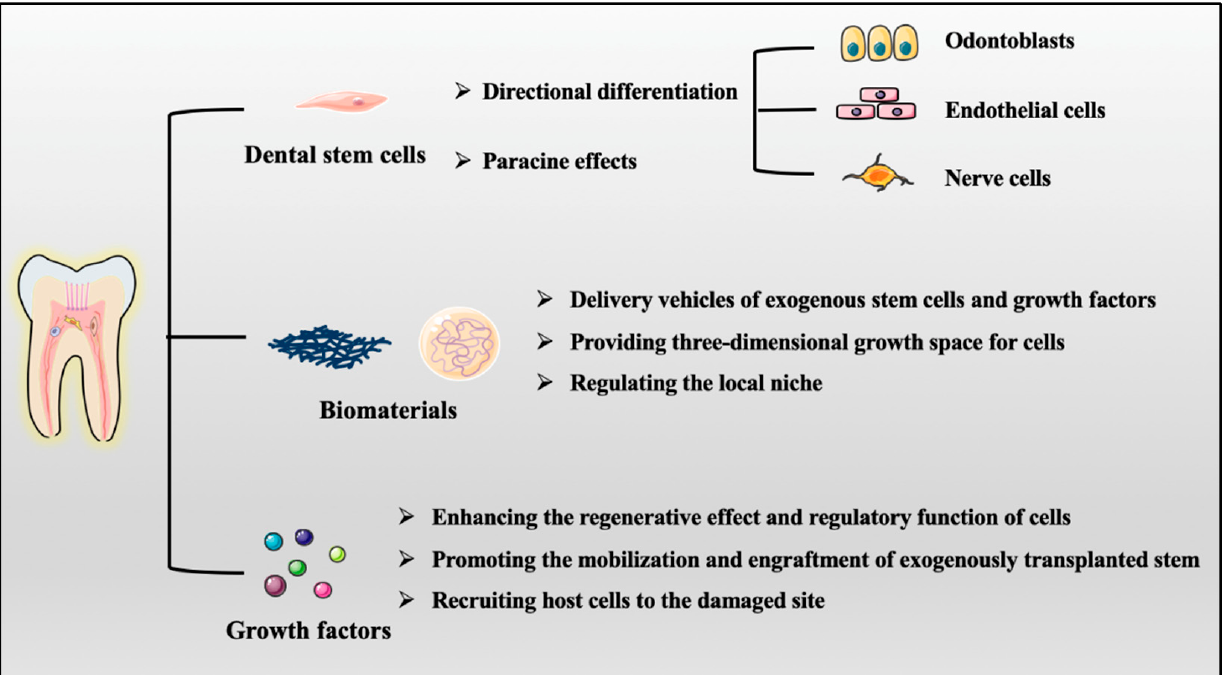
Figure 2. Three key elements in pulp regeneration: dental stem cells, biomaterials, and growth factors.